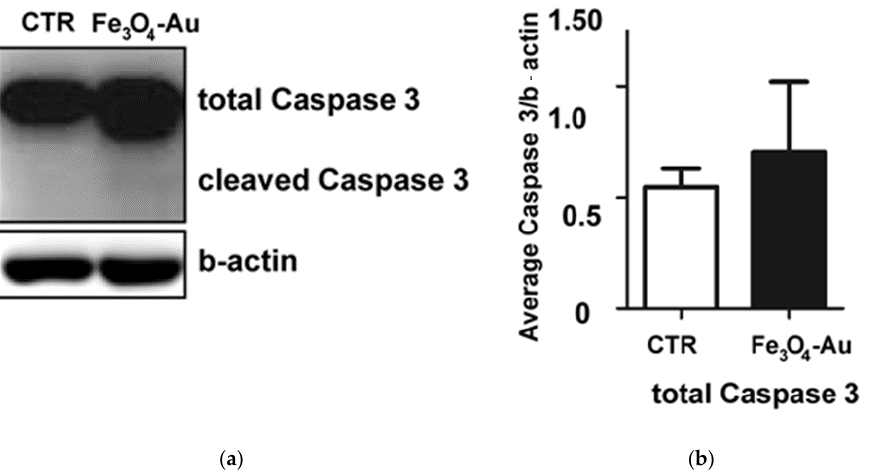
Figure 8. Western immunoblot analysis of the total and cleaved form of Caspase 3 in the Huh7 cell line. ( a ) Immunoblotting caspase 3 and b-actin. ( b ) Densitometric quantification of the total form of Caspase 3. Average band intensity after Western blotting of Caspase 3/b-actin. The data are expressed